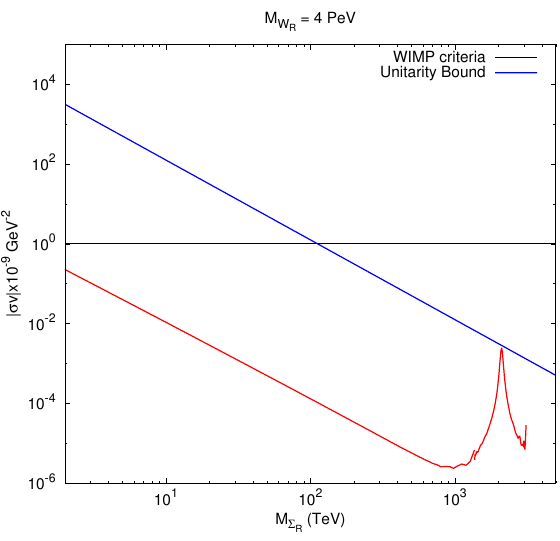
Figure 4 . Annihilation cross section of heavy dark matter (red line) in comparison to the cross section required to generate correct thermal relic abundance (black line) and the unitarity limit (blue line).